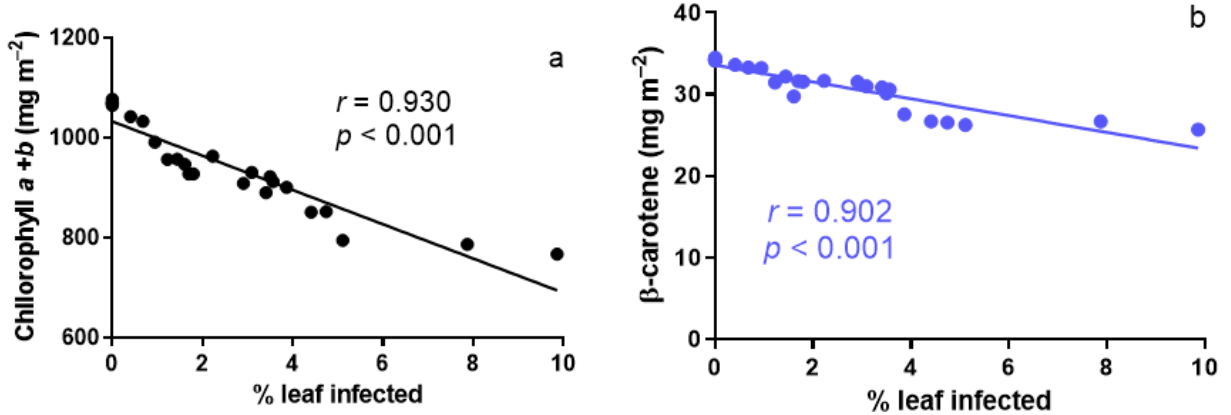
Figure 4. Correlations of chlorophyll a + b ( a ) and β-carotene ( b ) with the percentage of A. erinea infection in J. regia leaves ( n = 25). The same leaves as used for physiological measurements (Figures 2, 5, and 6). The data have been fitted using linear regression.